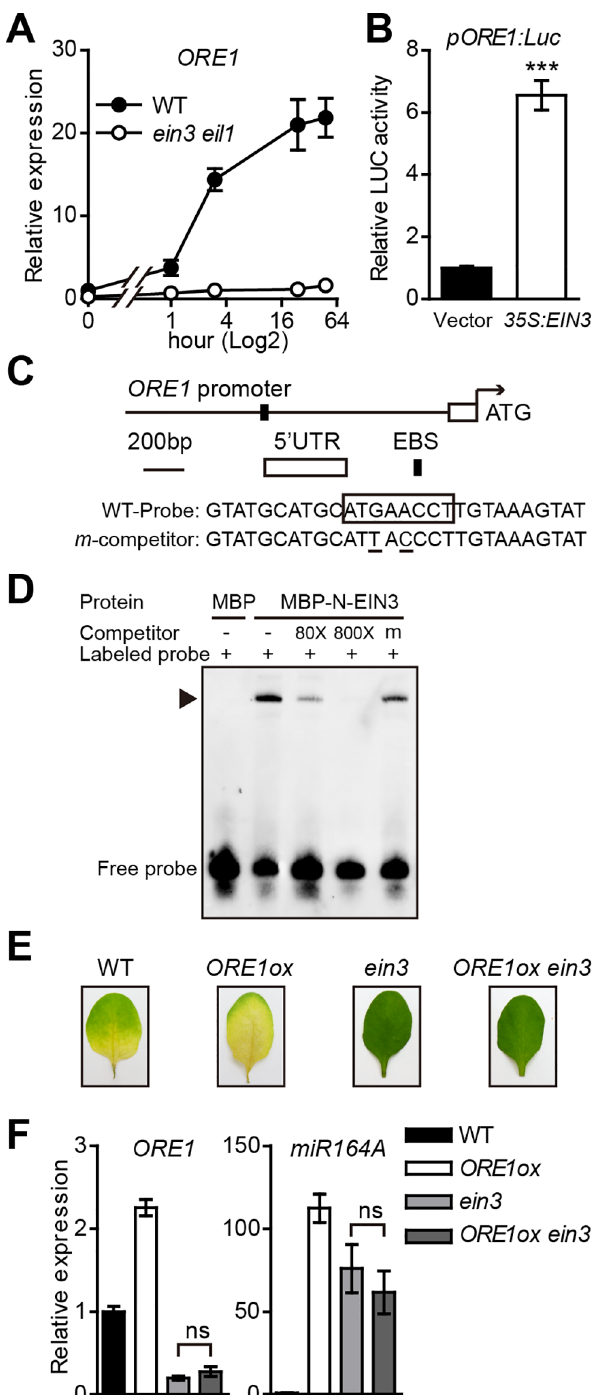
Fig 1. ORE1 is directly activated by EIN3 and repressed by miR164 . (A) Kinetic analysis of ORE1 expression in leaves of the wild-type (WT) and ein3 eil1 in response to ethylene treatment. Detached third and fourth rosette leaves from 4-week-old plants were treated with 100 μ L/L ethylene for various periods of times. RT-qPCR was performed to quantify the ORE1 mRNA levels. ACT2 was used as an internal control to normalize different samples. The mRNA level of ORE1 in the WT at 0 hr was arbitrarily set to 1. The x axis is shown in log2 scale. Data are mean ± SEM of 3 biological replicates with technical duplicates for each. (B) Transient dual-luciferase transactivation of the ORE1 promoter by EIN3 in protoplasts from Arabidopsis